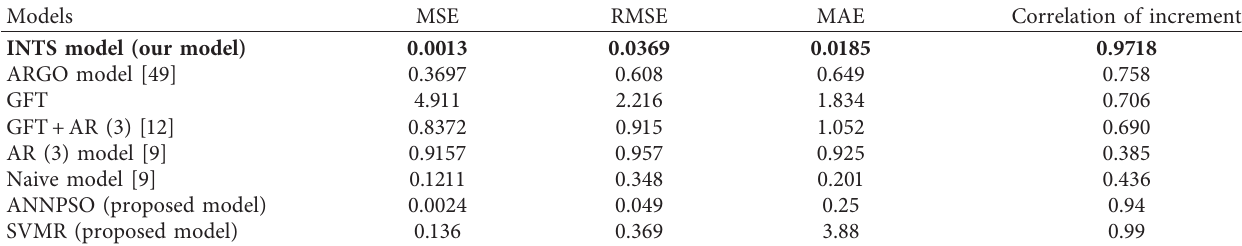
Table 4: Comparison of different models with the INTS model for the prediction of influenza epidemics using Google search queries. Models MSE RMSE MAE Correlation of